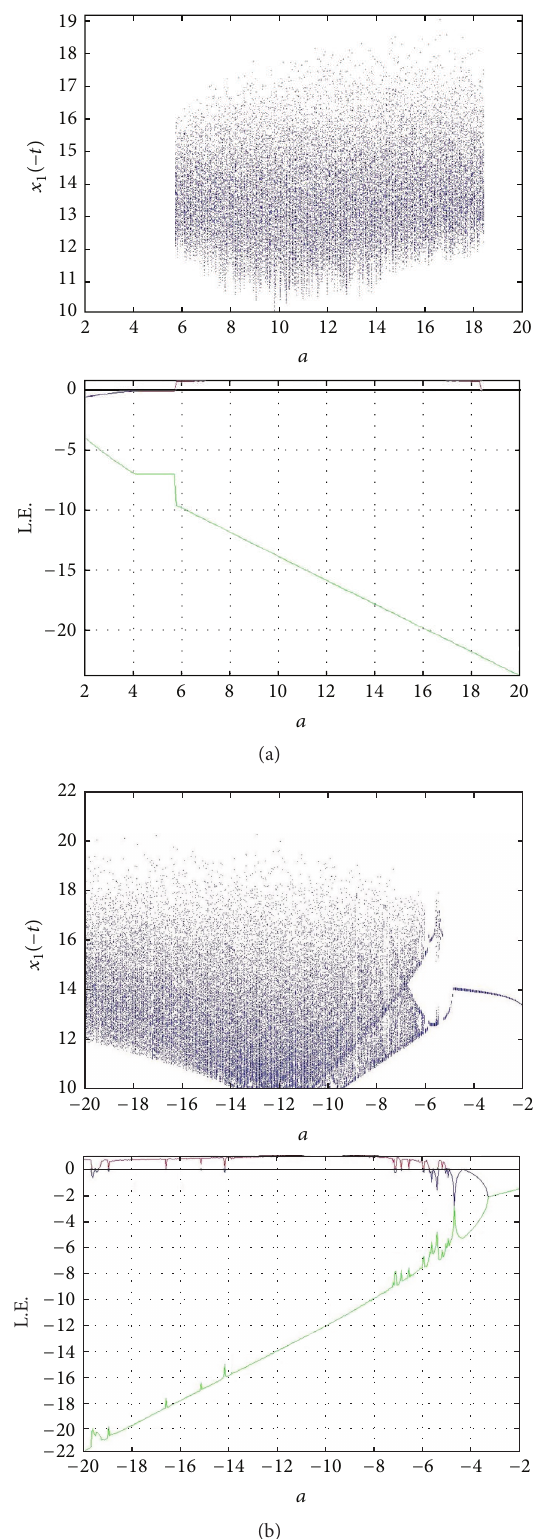
Figure 7: (a) Bifurcation diagram and Lyapunov exponents of chaotic classical Lorentz system with 𝑏 = 8/3 and 𝑐 = 28 . (b) Bifurcation diagram and Lyapunov exponents of chaotic time- reversed Lorentz system with 𝑏 = −8/3 and 𝑐 = −28 . The tables given previously show the different dynamic characters between classical and time-reversed Lorentz systems with different ranges of parameter 𝑎